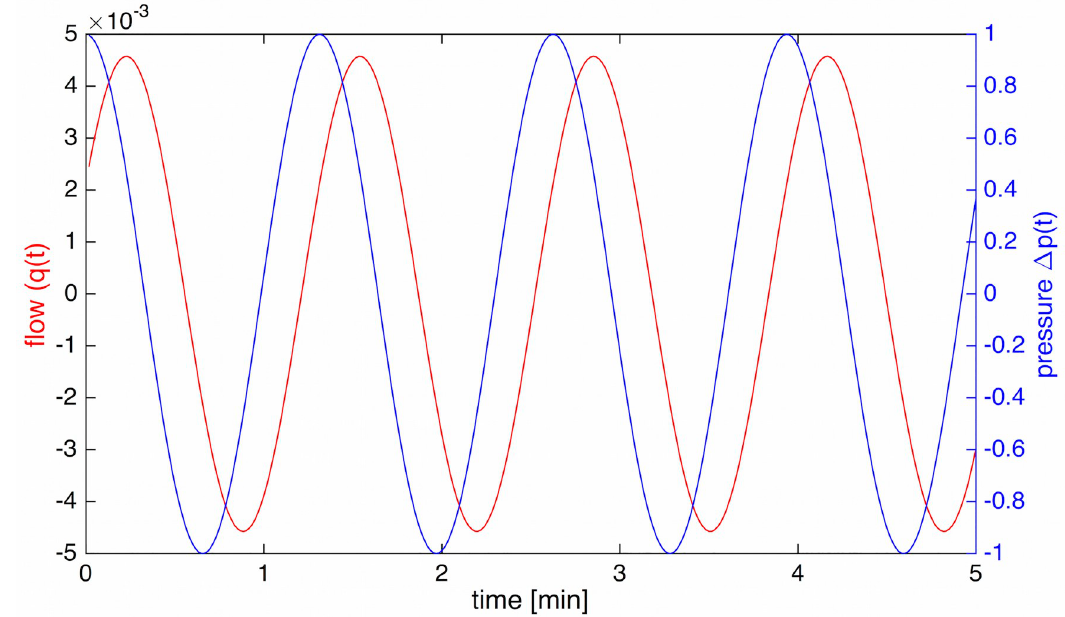
Fig 10. Phase difference between pressure and flow. Pressure ( Δ p ( t )) and flow rate ( q ( t )). Flow lags θ = 62˚ behind the pressure wave.